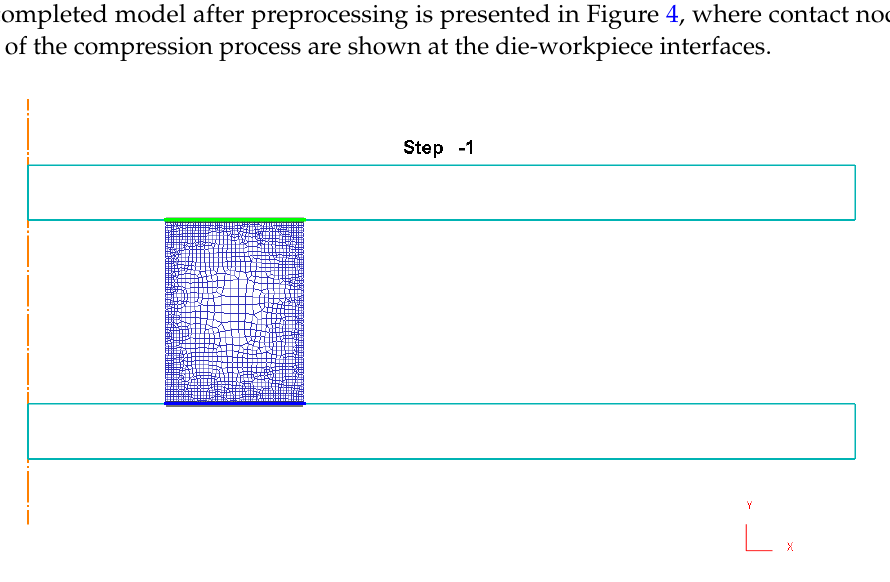
Figure 4. Finite Element model by DEFORM F2™ after preprocessing.